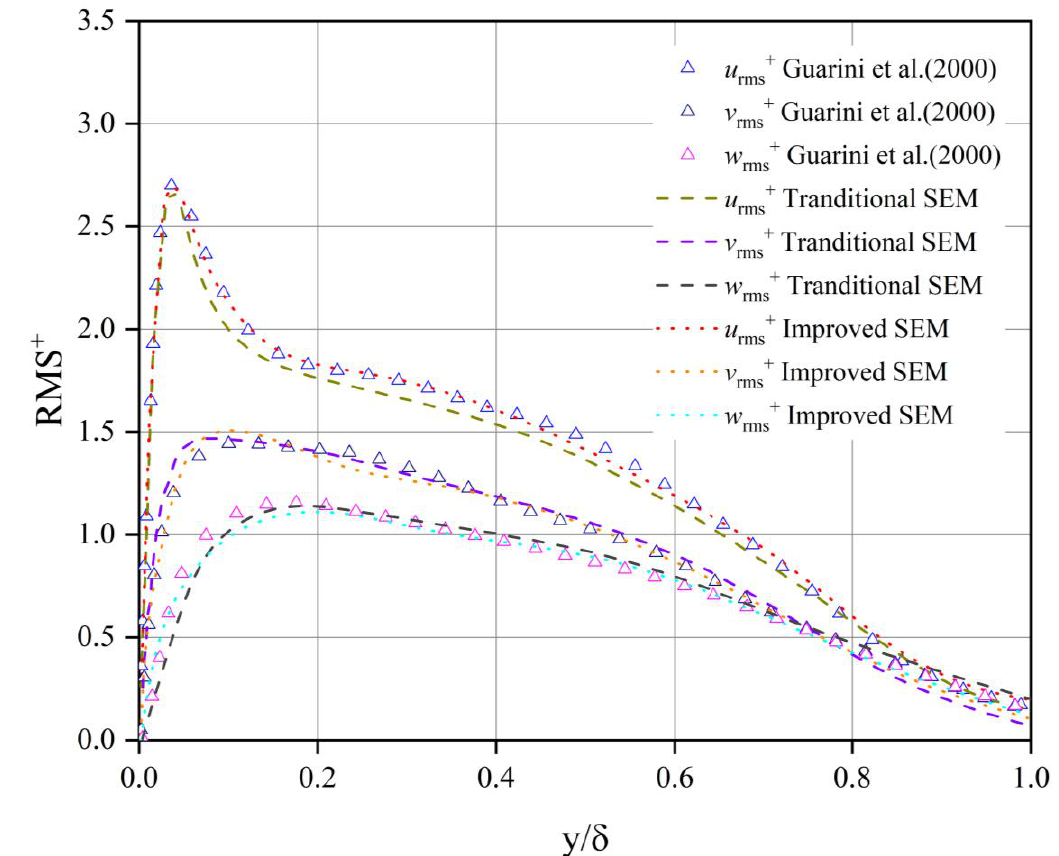
Figure 14. Root mean square velocity distribution at x = 12 δ for different